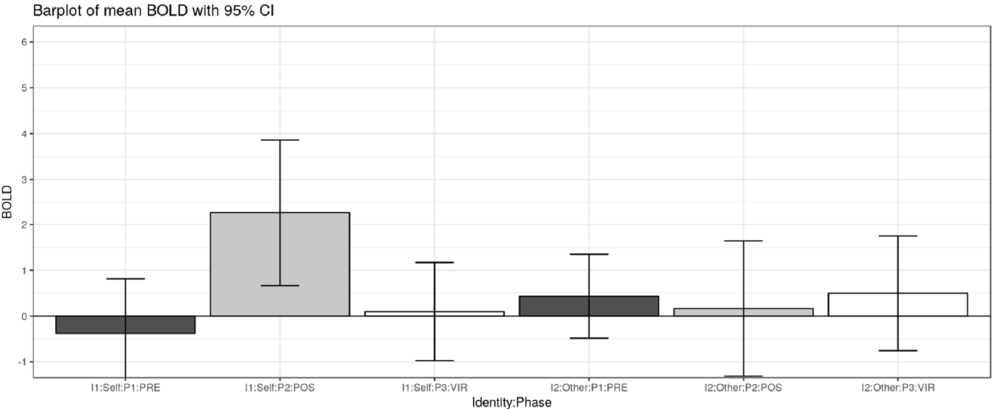
Figure 2. Barplot of mean ± or standard error, identity by phase interaction effect (SELF/OTHER vs. PRE/POS).